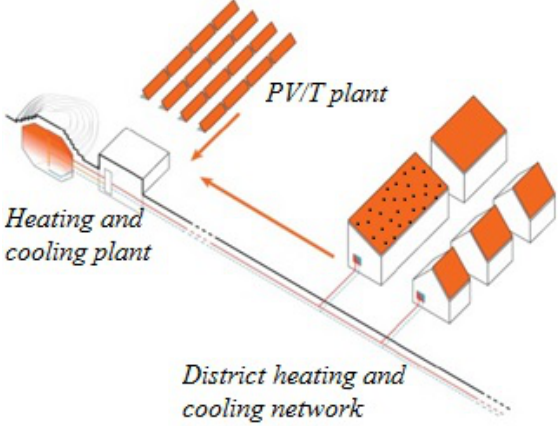
Figure 11. PV/T district heating and